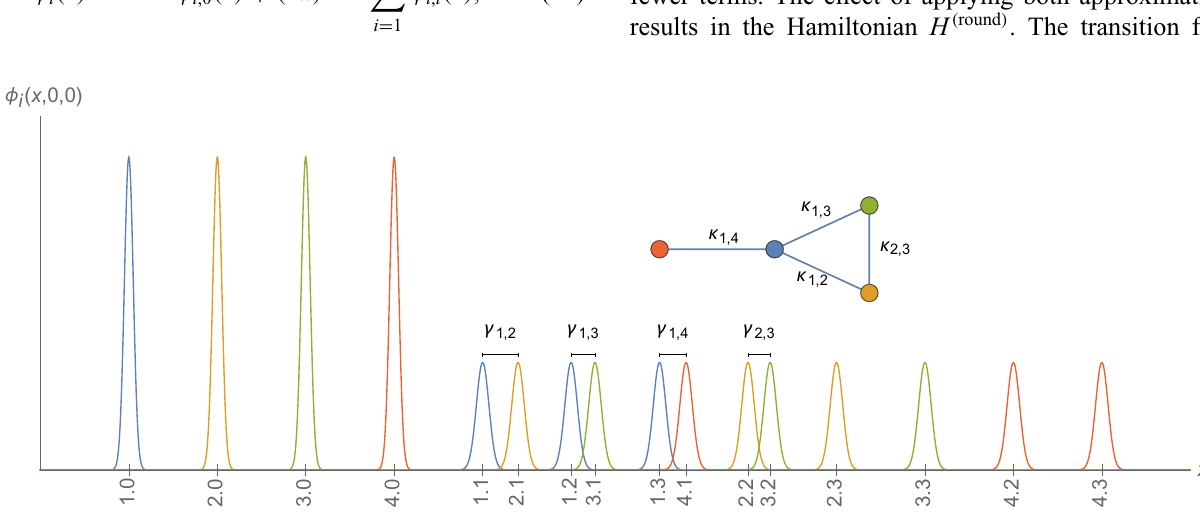
(cid:9) (cid:8) κ as in Eq. (11). It has degree i , j { i , j }∈ E